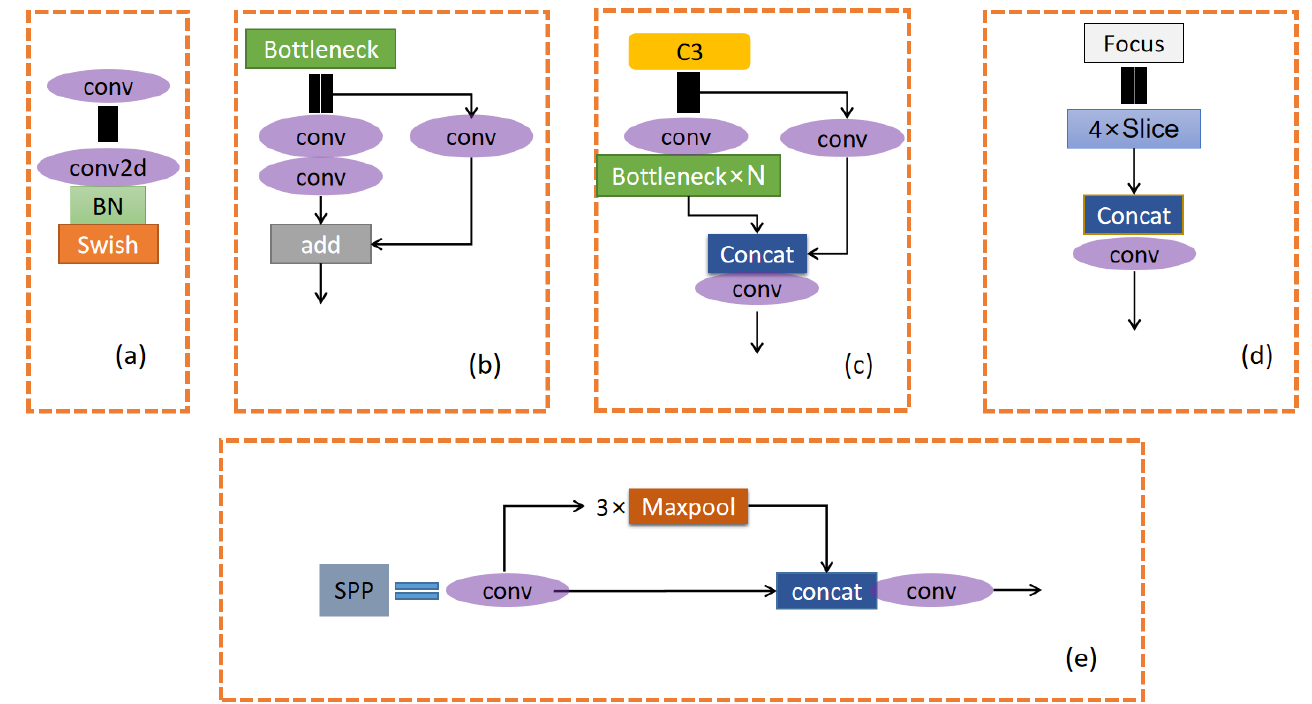
Figure 2. Schematic diagram of each module structure in the Model E network structure. ( a ) Conv module structure diagram; ( b ) Bottleneck module structure diagram; ( c ) C3 module structure diagram; ( d ) Focus module structure diagram; ( e ) SPP module structure diagram (Concat_B is an improved BiFPN module structure, Ghost-Conv is an improved Ghost convolution operation, and conv is a conventional convolution operation. The specific improvement methods are described in detail in the following two sections.).